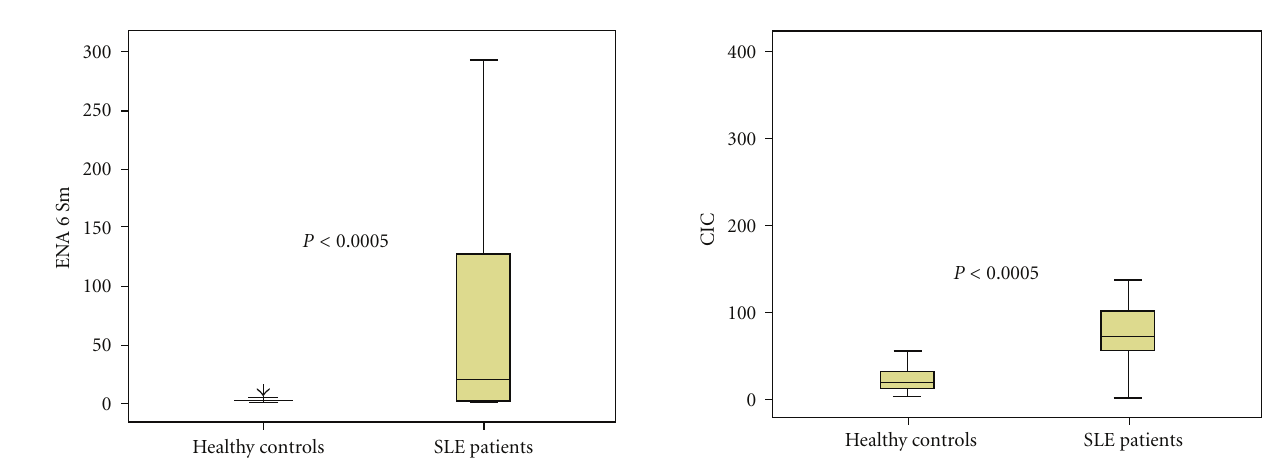
Figure 1: Serum ENA6 Sm concentration in healthy controls and SLE patients. Each bar shows upper and lower quartile, while the square and its central bar indicate interquartile range and median.